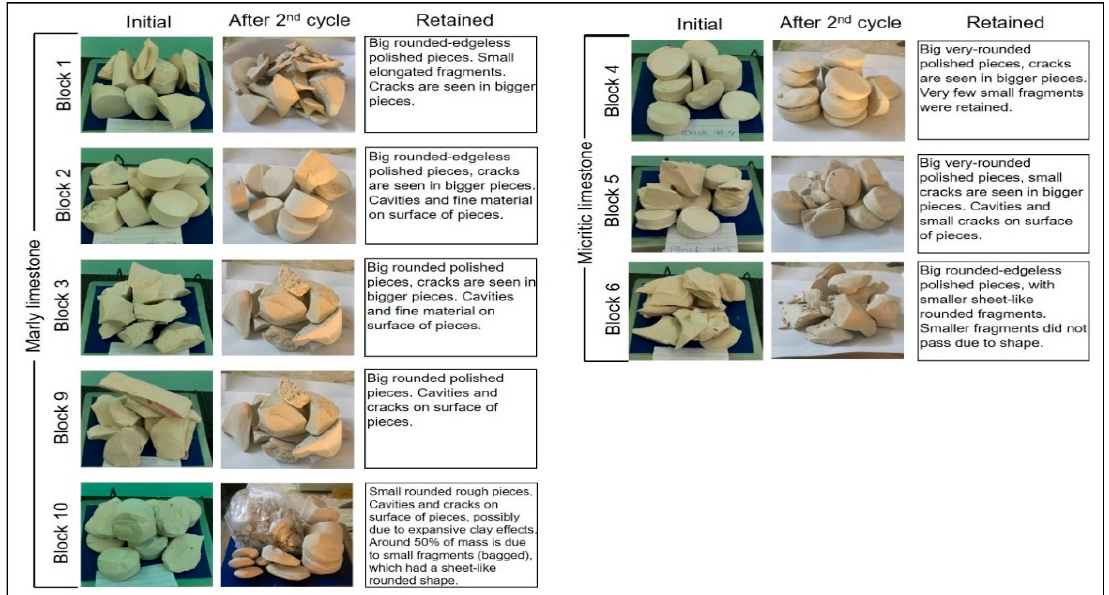
Figure A1. Slake durability tests. Original tested subsamples and retained fragments after the second cycle of slaking. Description of retained fragments have been added along with differentiation by blocks and lithology. There were no differences in colour between samples, though pictures were taken at different light intensities.